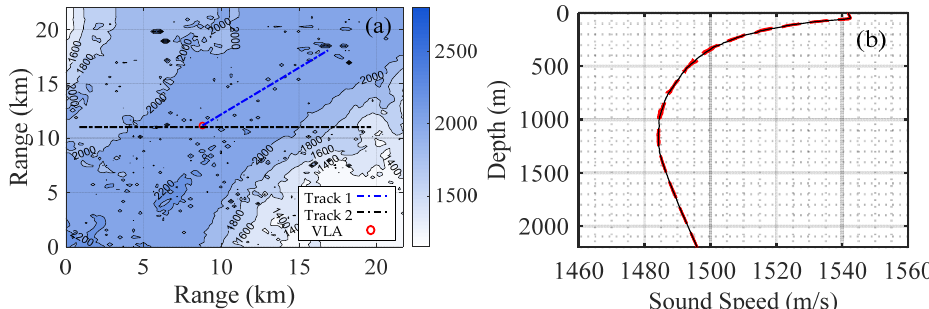
Figure 1. ( a ) Bathymetry and survey lines in the experimental area as also presented in [14]. The contours represent the water depths in this area. The dashed blue line represents track 1, the dashed black line (horizontal) represents track 2, and the red circle (at the intersection of dashed blue and black lines) represents the position of the vertical line array. ( b ) Sound speed profiles measured in situ using conductivity, temperature, and depth (CTD). The red line represents the CTD measurements, and the black line is the average.